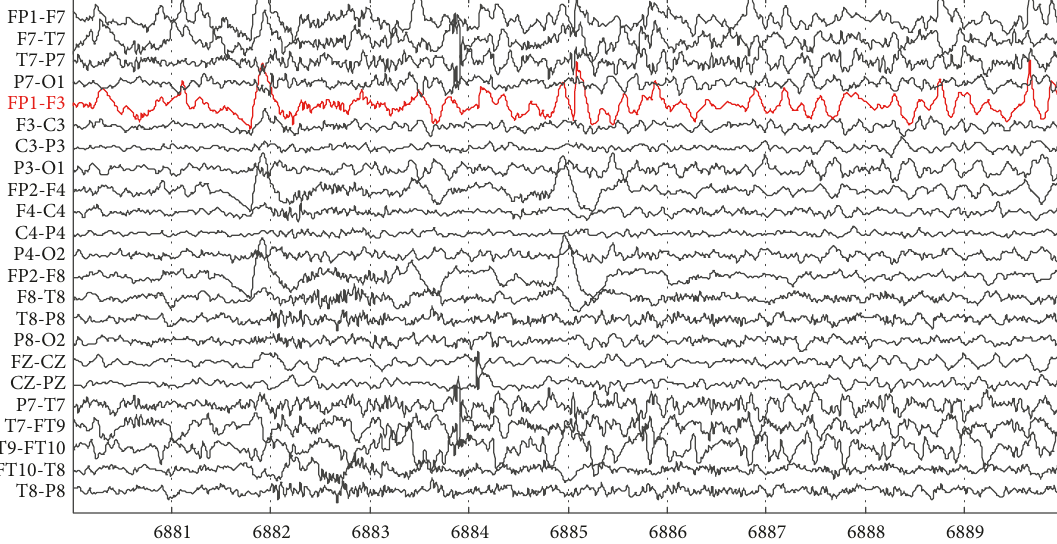
Figure 4: The continuous scalp EEG recordings with another seizure in Patient I. The EEG channels (FP1-F3) involved in a seizure were marked as